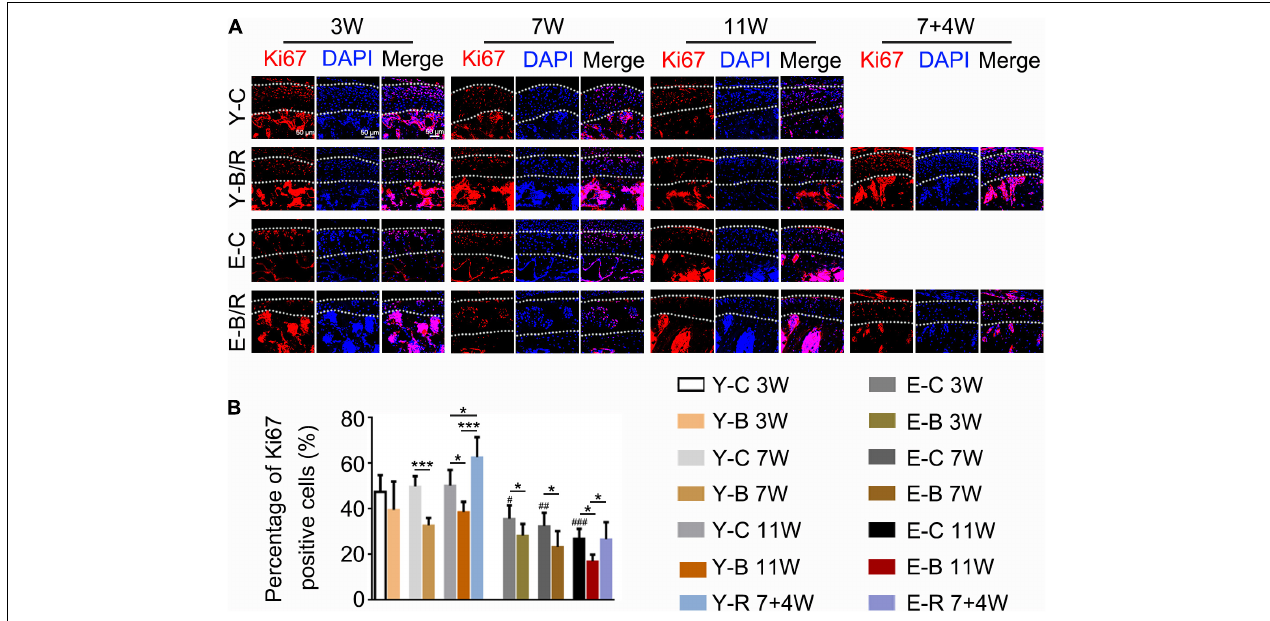
FIGURE 11 | (A) Representative Ki67 immunofluorescence staining. Bars = 50 µ m. (B) Comparisons of the percentage of Ki67-positive cells in the cartilage between the groups. Data are presented as mean ± SD. Unpaired t -test was used for comparisons between the age-matched control and BAC groups. One-way ANOVA was used for comparisons among the age-matched control, BAC, and BAC removal groups, and the comparisons among the six time points in control groups. n = 6. * P < 0.05, *** P < 0.001 for the differences between all BAC and removal groups and the age-matched control groups. # P < 0.05, ## P < 0.01, ### P < 0.001 for the differences between each time points control groups and the younger 3-week control group. For the grouping and time points, please refer to Figure 1A .